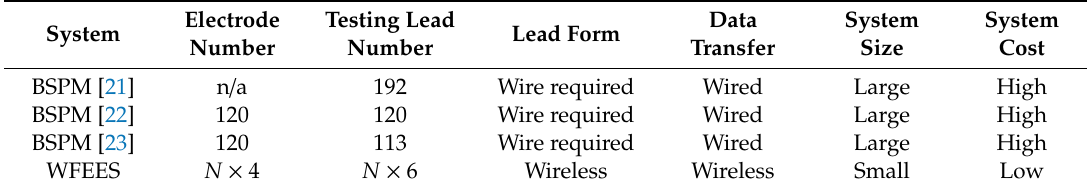
Figure 4. The block diagram of the layered ( A , N ) square-based (LANS) method, including the coarse- grained stage and the fine-grained stage.